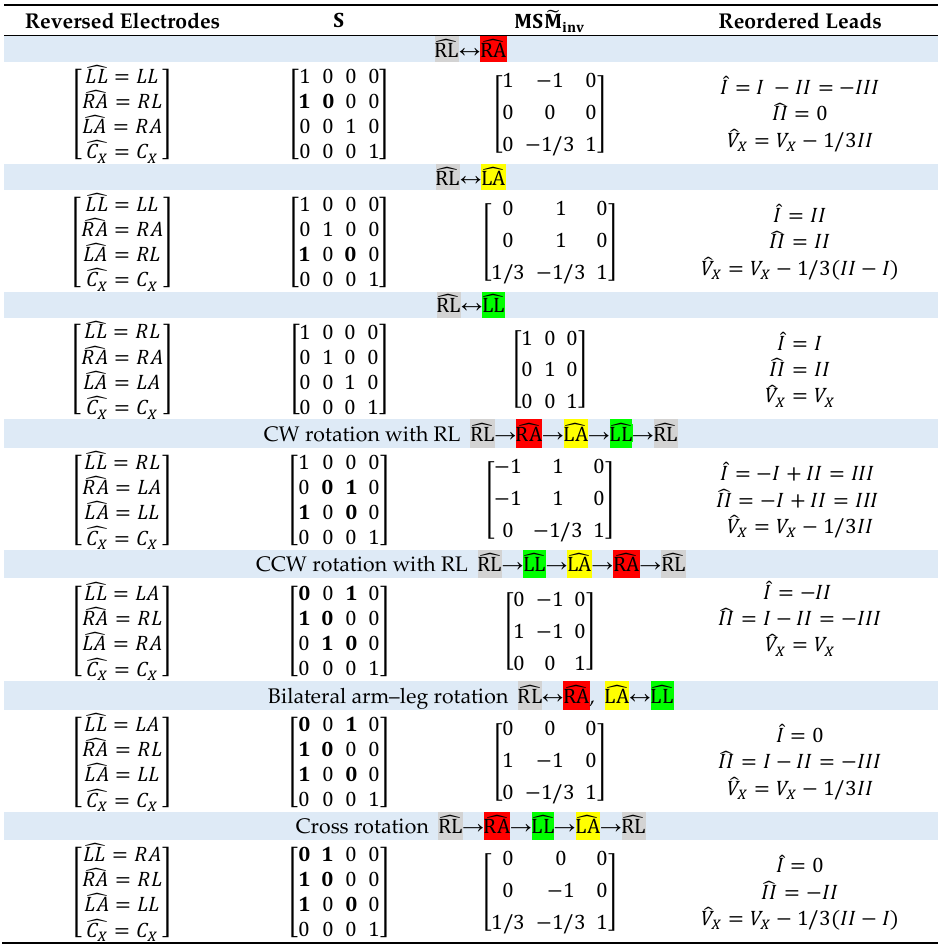
Table 3. Reversals of peripheral electrodes involving RL.